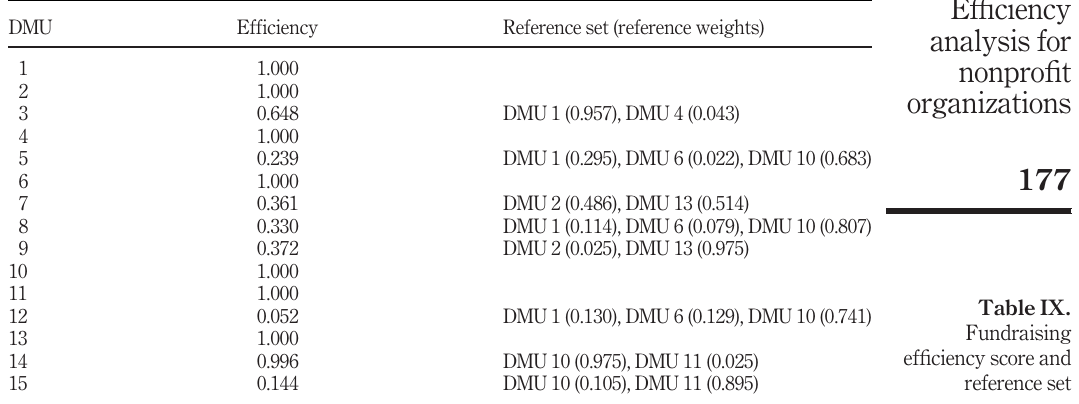
Table IX. Fundraising ef fi ciency score and reference set